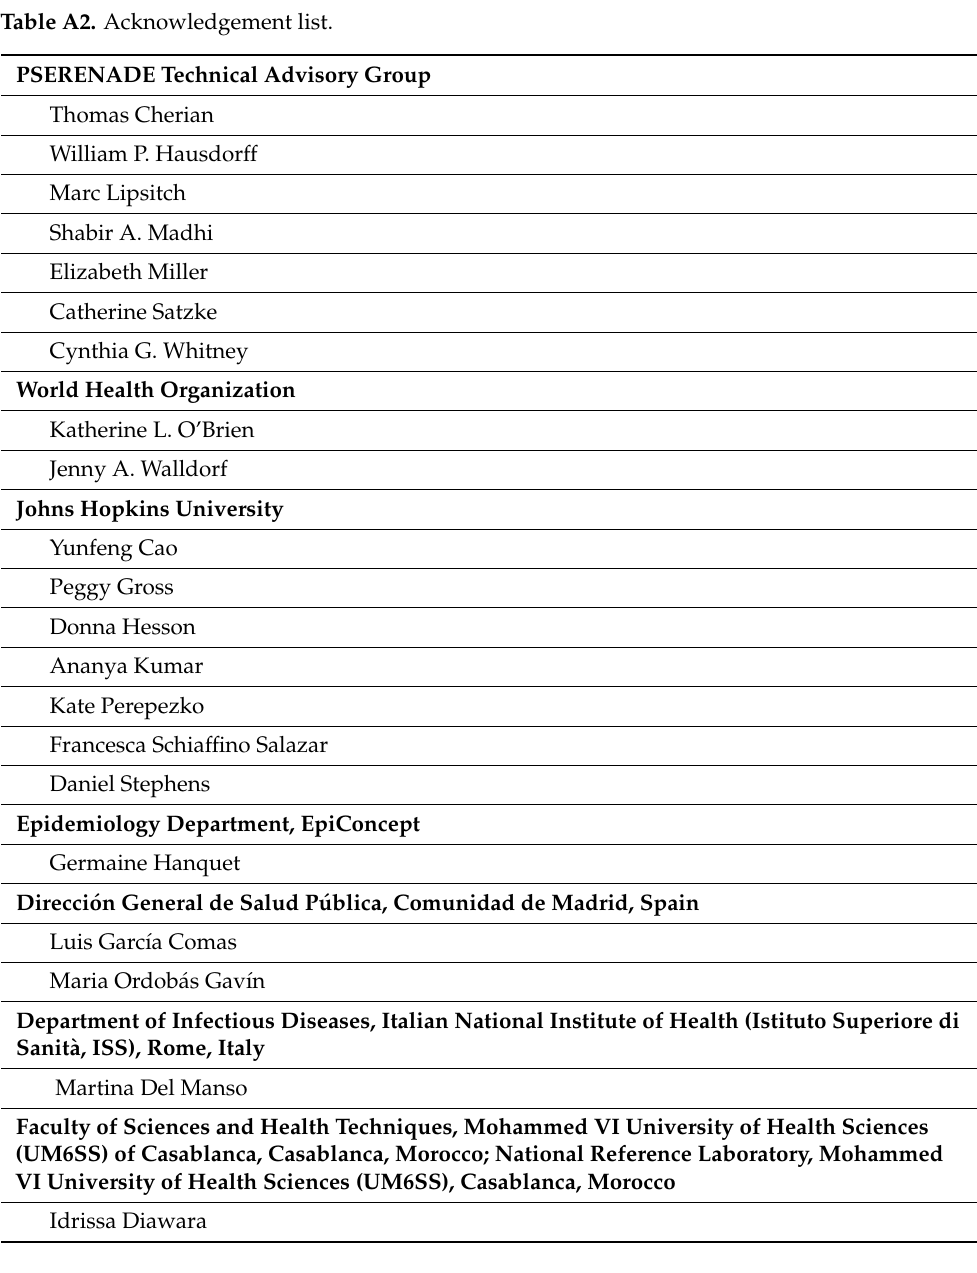
Table A2. Acknowledgement